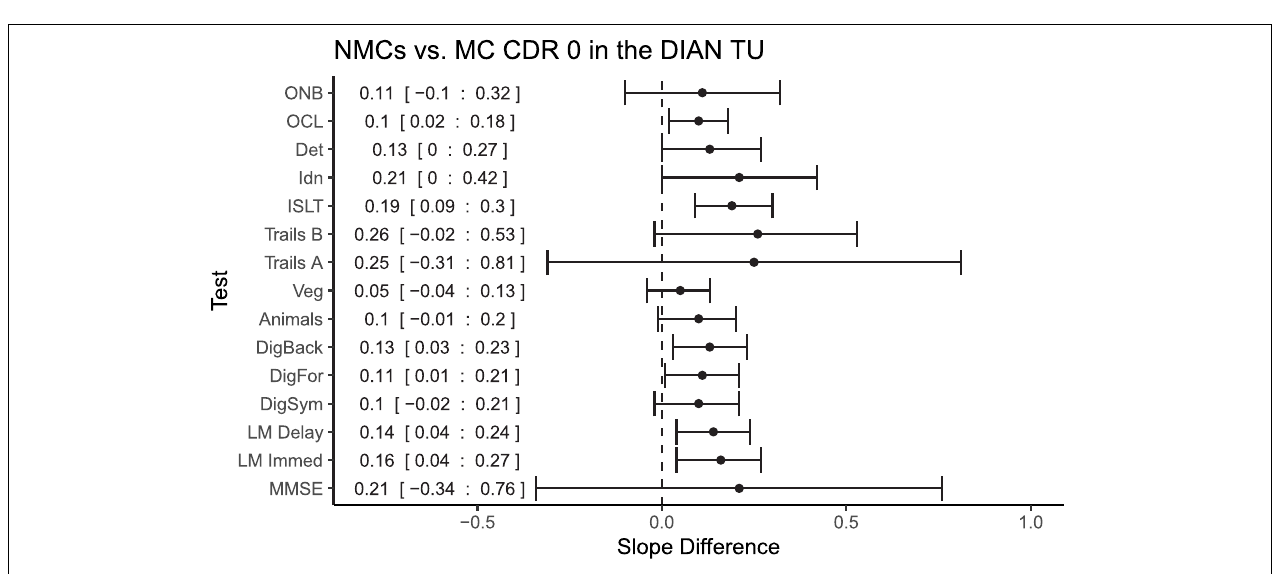
FIGURE 1 | Slope estimates and 95% confidence intervals for each test and clinical group in the Dominantly Inherited Alzheimer Network Trials Unit (DIAN-TU). Slopes can be considered significant if the CI does not encompass zero. All tests were scaled such that a negative slope indicates decline. Slopes are in z-score units change per year. (A) Plots non-carriers ( N = 46), (B) plots Clinical Dementia Rating (CDR) 0 mutation carriers ( N = 85), and (C) plots CDR > 0 mutation carriers ( N = 59). Due to dramatic performance differences across groups, the X-axis scale is not identical across the panels. ONB, one-back; OCL, one card learning; Det, detection; Idn, identification; ISLT, international shopping list; Veg, category fluency for vegetables; animals, category fluency for animals; DigFor and DigBack, digit span forward and backward; LM, logical memory; MMSE, Mini Mental State Exam.